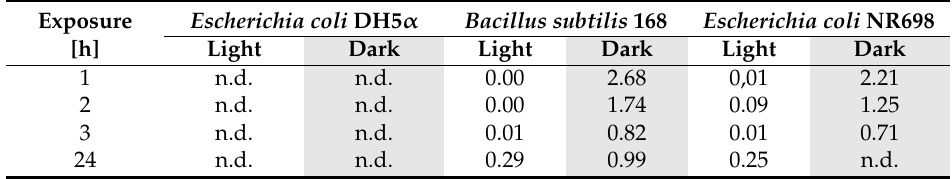
Table 4. EC 50 values for chlorophyllin in mg/L, determined in light (bright columns) or darkness (grey